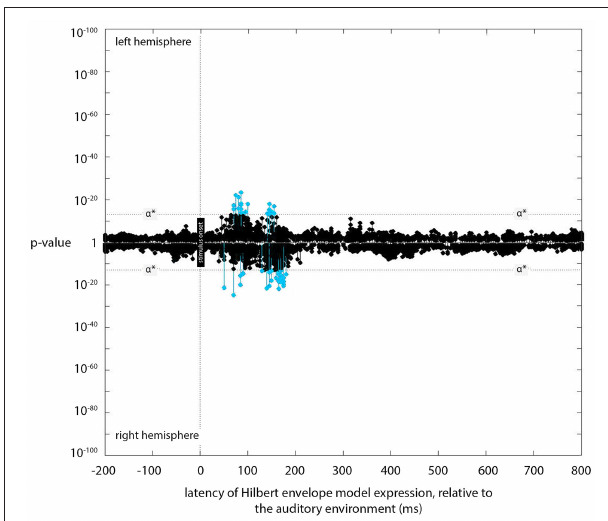
FIGURE 4 | Expression plot for the Hilbert envelope model. Plot of expression of the Hilbert envelope model (across processing lags from − 200 to + 800ms, relative to the acoustic signal), showing the latencies of significant expression with the Hilbert